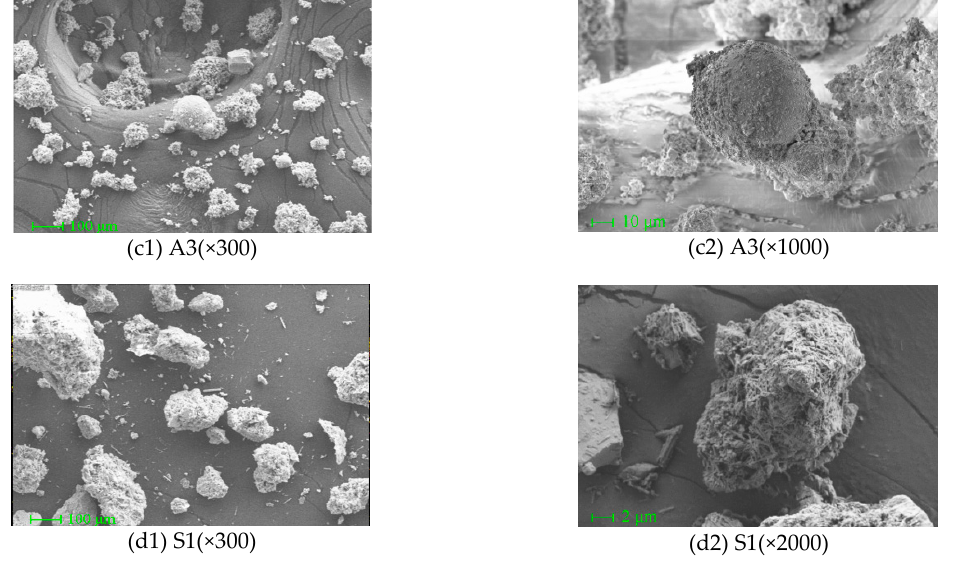
Figure 11. SEM of waste incineration ash and slag: ( a1 ) SEM image of the cyclone separator ash at 300x magnification; ( a2 ) SEM image of the cyclone separator ash at 1300x magnification; ( b1 ) SEM image of the horizontal flue ash at 300x magnification; ( b2 ) SEM image of the horizontal flue ash at 1000x magnification; ( c1 ) SEM image of the bag filters ash at 300x magnification; ( c2 ) SEM image of the bag filters ash at 1000x magnification; ( d1 ) SEM image of the slag at 300x magnification; ( d2 ) SEM image of the slag at 2000x magnification.